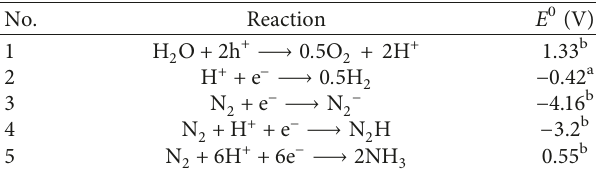
n ): metal oxide-based materials as − 2 to NH 3 [10–12]].